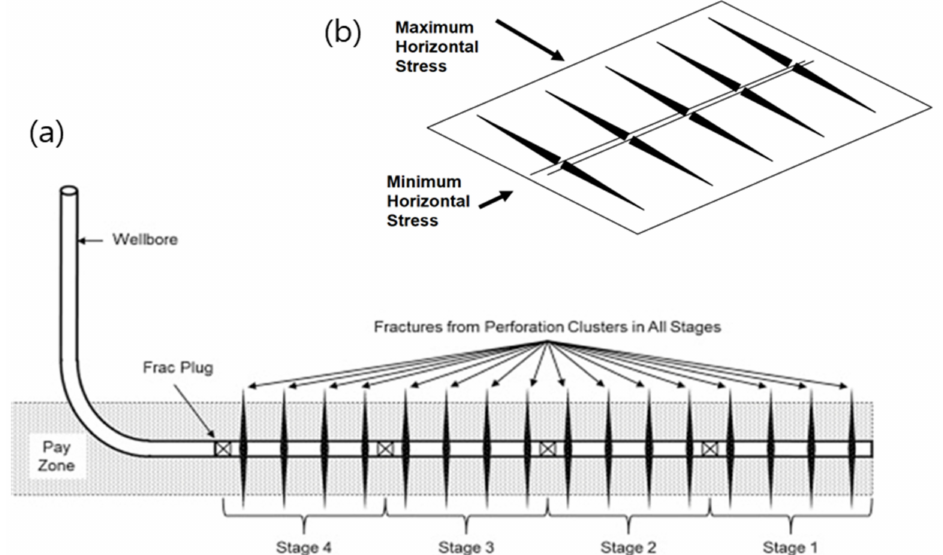
Figure 1. ( a ) Wellbore schematic of multi-fractured horizontal well completed with so-called plug and perf method (after Guo et al. [2]). In this example, each fracture stage has three perforation clusters from where the fractures are initiated during the fracture treatment. ( b ) Typical orientation of the principal stresses relative to the horizontal well direction immediately prior to hydraulic